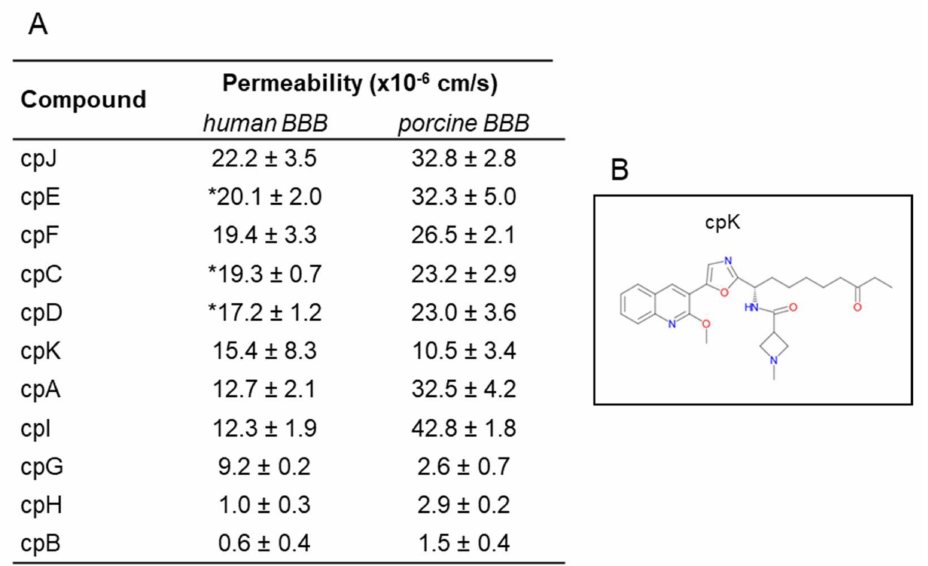
Figure 7. Permeability of investigational compounds. ( A ) Permeability values of investigational compounds in the in vitro human and porcine BBB models. Permeability values are expressed as mean ± sd from at least three biological replicates. * Compounds were tested in two clones (Cl1 and Cl2), values are expressed as mean ± SEM. ( B ) Chemical structure of